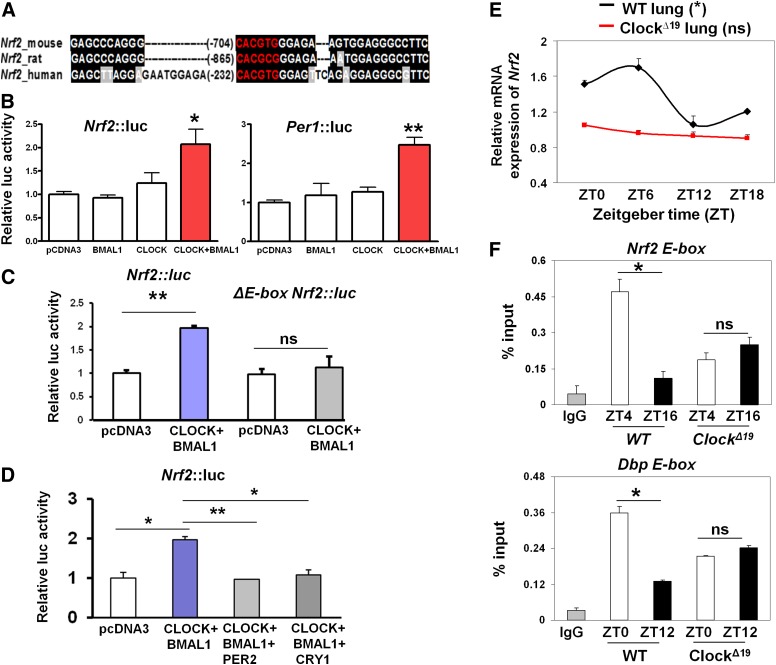
Circadian clock components control Nrf2 transcription via a putative E-box element in vitro and in vivo. (A) A conserved putative E-box element (shown in red) in the proximal promoters of the mouse, rat, and human Nrf2 gene. Sequences were aligned using the Clustal W algorithm and shaded with the Boxshade algorithm to highlight the conserved regions (shown in black). (B, C) Effects of CLOCK/BMAL1 overexpression on wild-type (WT) or ΔE-box Nrf2∷luc promoter activity in Rat1 cells. Data (mean ± SEM) were normalized to the β-galactosidase reporter gene and expressed relative to pCDNA3 control. The Per1∷luc reporter served as a positive control. (*) P < 0.05; (**) P < 0.01; (ns) not significant, t-test. (D) Effects of PER2 or CRY1 overexpression in suppressing the CLOCK/BMAL1-activated Nrf2∷luc promoter activity in Rat1 cells. (*) P < 0.05; (**) P < 0.01, t-test. (E) Temporal mRNA expression of Nrf2 in wild-type and ClockΔ19 lungs. Data (mean ± SEM) were normalized to Gapdh. (*) P < 0.05 for wild-type lungs;( ns) not significant for ClockΔ19 lung; one-way ANOVA for the effect of time. (F) Temporal CLOCK binding to E-boxes in Nrf2 and Dbp gene promoters in wild-type and ClockΔ19 lungs using CLOCK-specific ChIP. IgG served as a negative control. Data (mean ± SEM) were expressed as percent input. (*) P < 0.05; (ns) not significant, t-test. (White bar) Light phase; (black bar) dark phase.